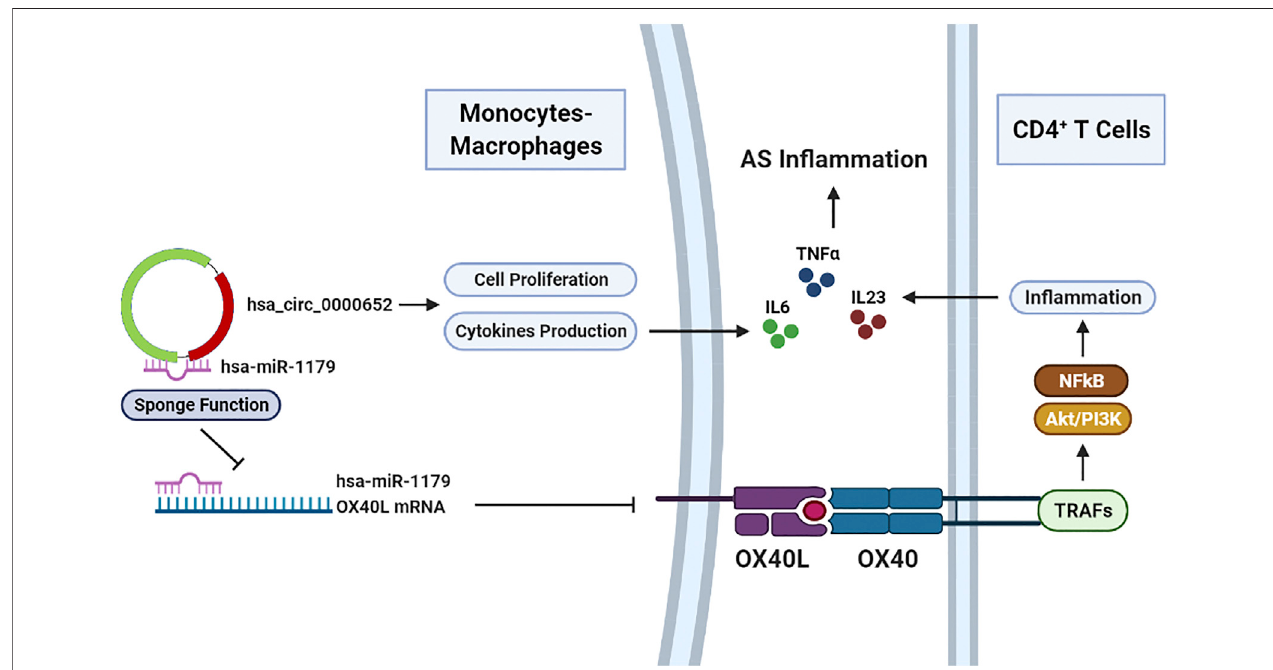
FIGURE7| Hsa_circ_0000652servesasapro-in fl ammatoryfactorinmacrophageactivationandanenhancerofOX40/OX40Linteractionbetweenmacrophages and CD4 + T cells.